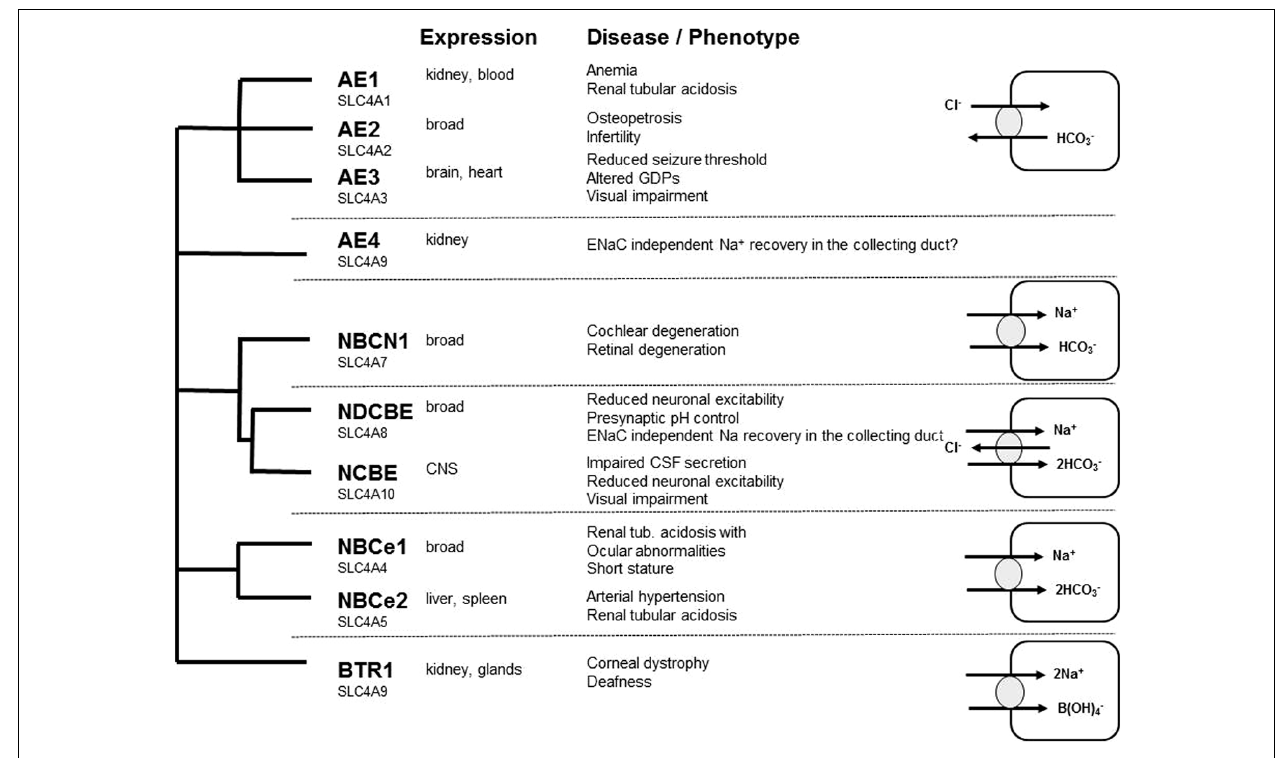
FIGURE 2 | Overview of the SLC4A family of bicarbonate transporter: expression, loss of function phenotypes, and transport characteristics.